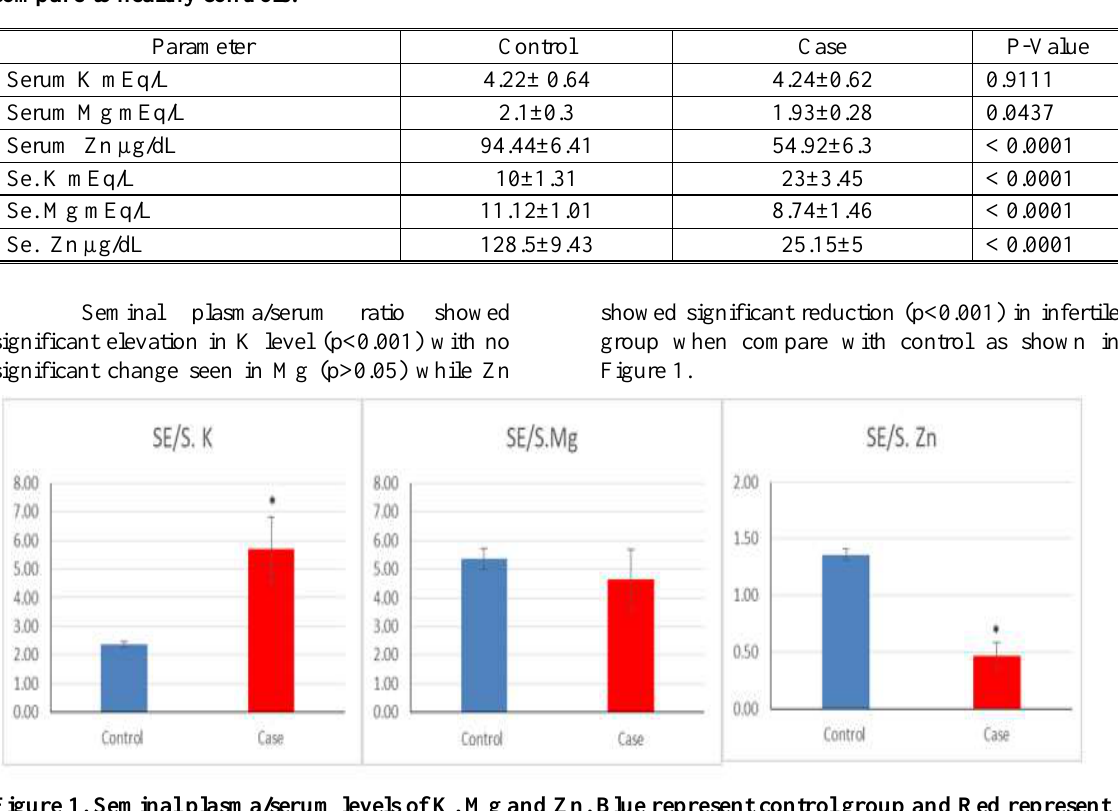
Figure 1. Seminal plasma/serum levels of K, Mg and Zn. Blue represent control group and Red represent infertile male